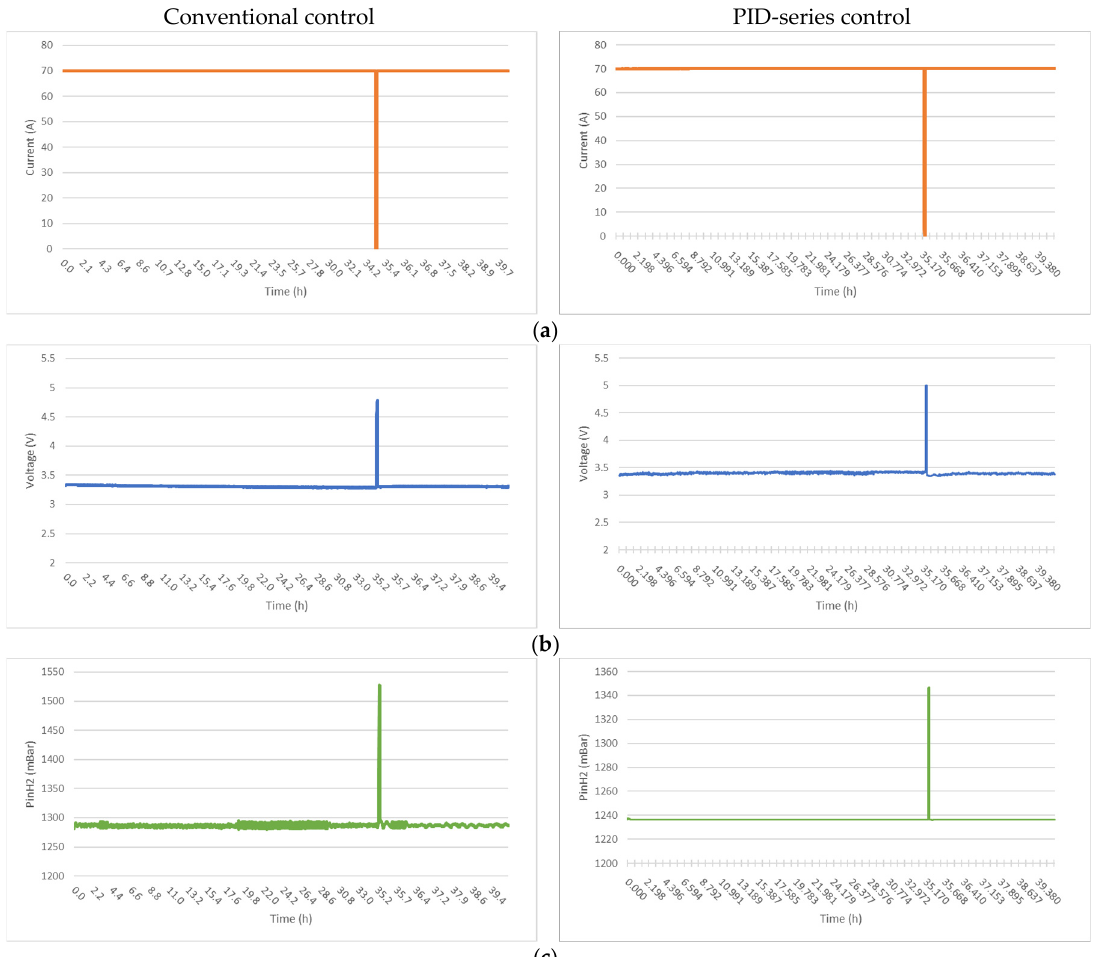
Figure 12. Performance analysis of PID-series and conventional control. ( a ) The same load was connected to both controllers. At time 35.42 h the load was changed to evaluate the effect on the output voltage and the supply hydrogen pressure; ( b ) The output voltage reached the same level in steady state in both cases practically. When the load connected was reduced (until open circuit) the output voltage increased; ( c ) Hydrogen pressure in the conventional control (left) oscillated (in the steady state) mainly between 1280 and 1295 mBar, whereas in the neuro-control (right), the hydrogen pressure remained practically constant at 1238 mBar in the steady state.